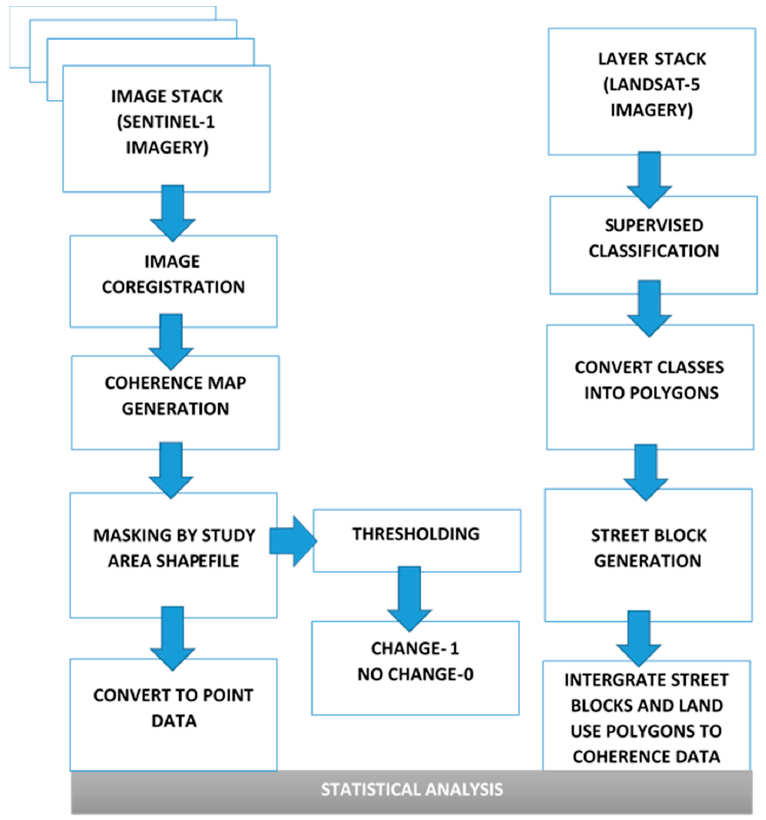
Figure 1. Methodology workflow.